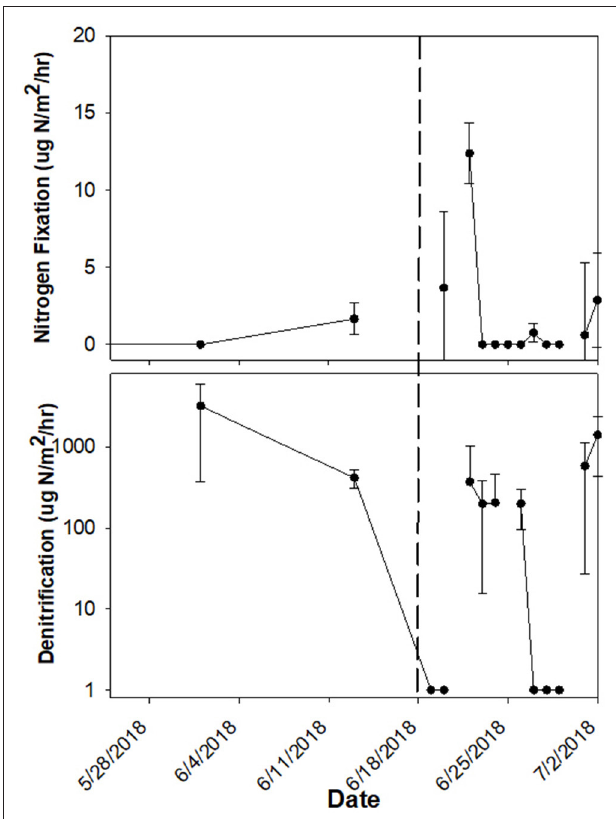
FIGURE 7 | N 2 fixation rate on rock and denitrification rate in sediment before and after the 1,000-year flood on 18 June 2018 (indicated by vertical dashed